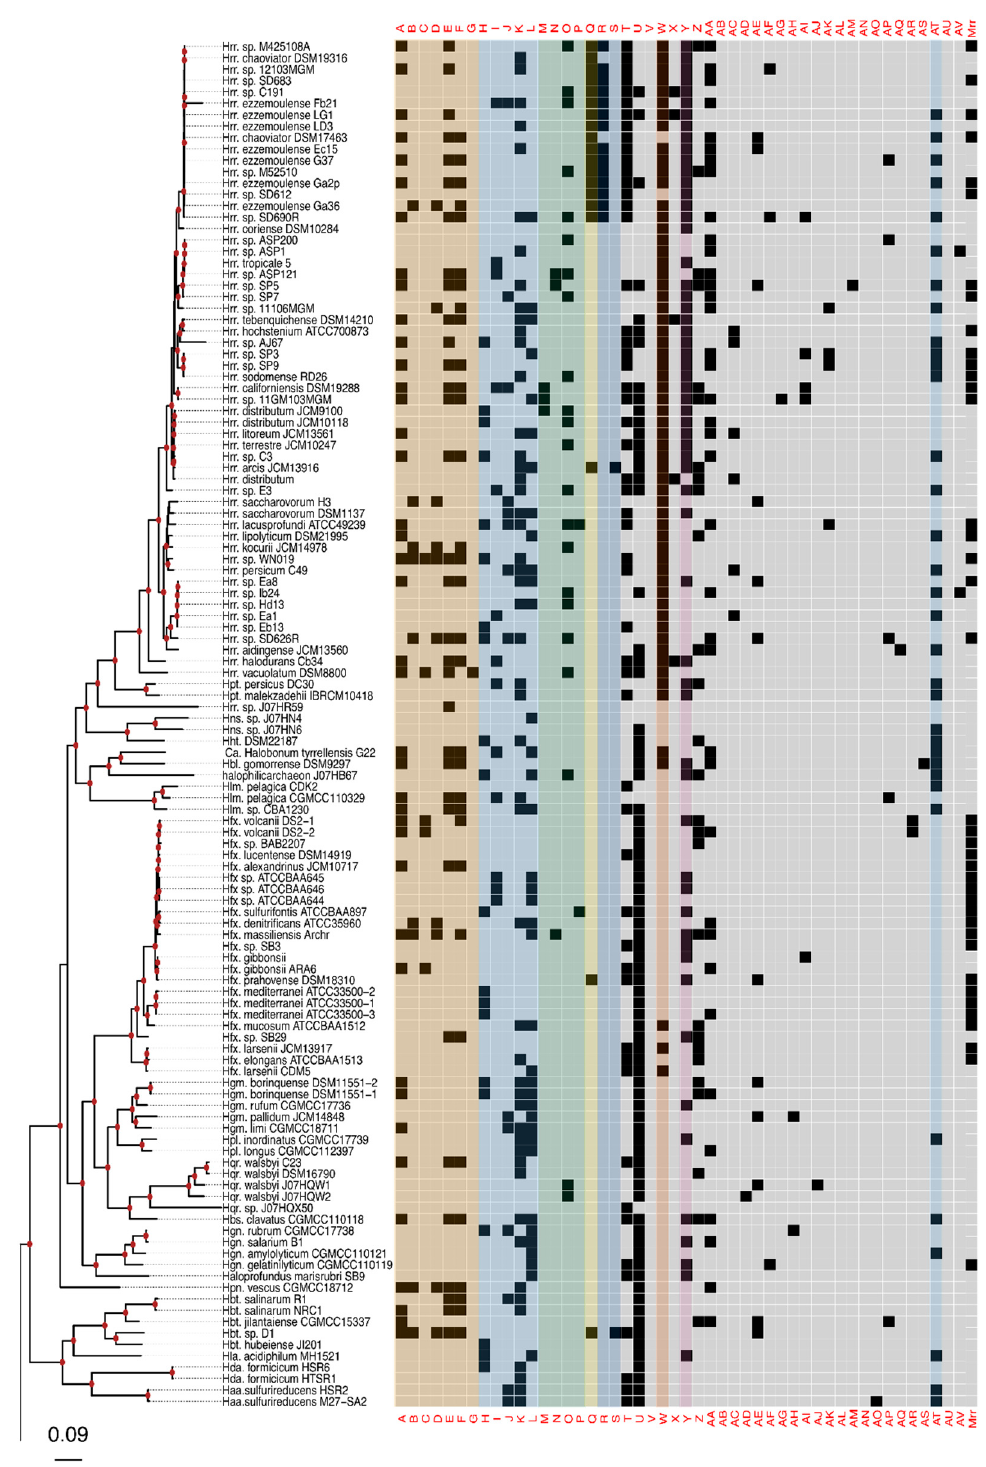
Figure 2. Figure 2. Cont.